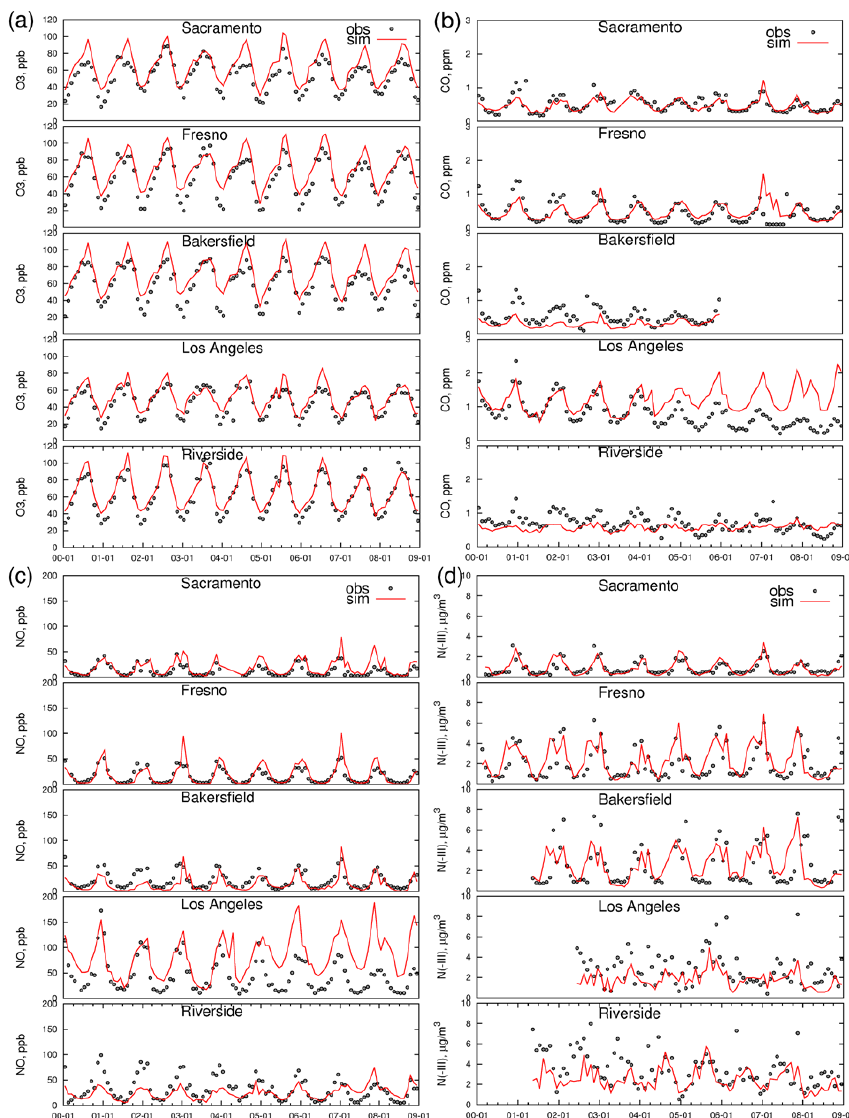
Figure 5. Predicted (red lines) vs. observed (dark dots) monthly average O 3 (a) , CO (b) , NO (c) , and PM 2 . 5 ammonium (d) at Sacramento, Fresno, Bakersfield, Los Angeles, and